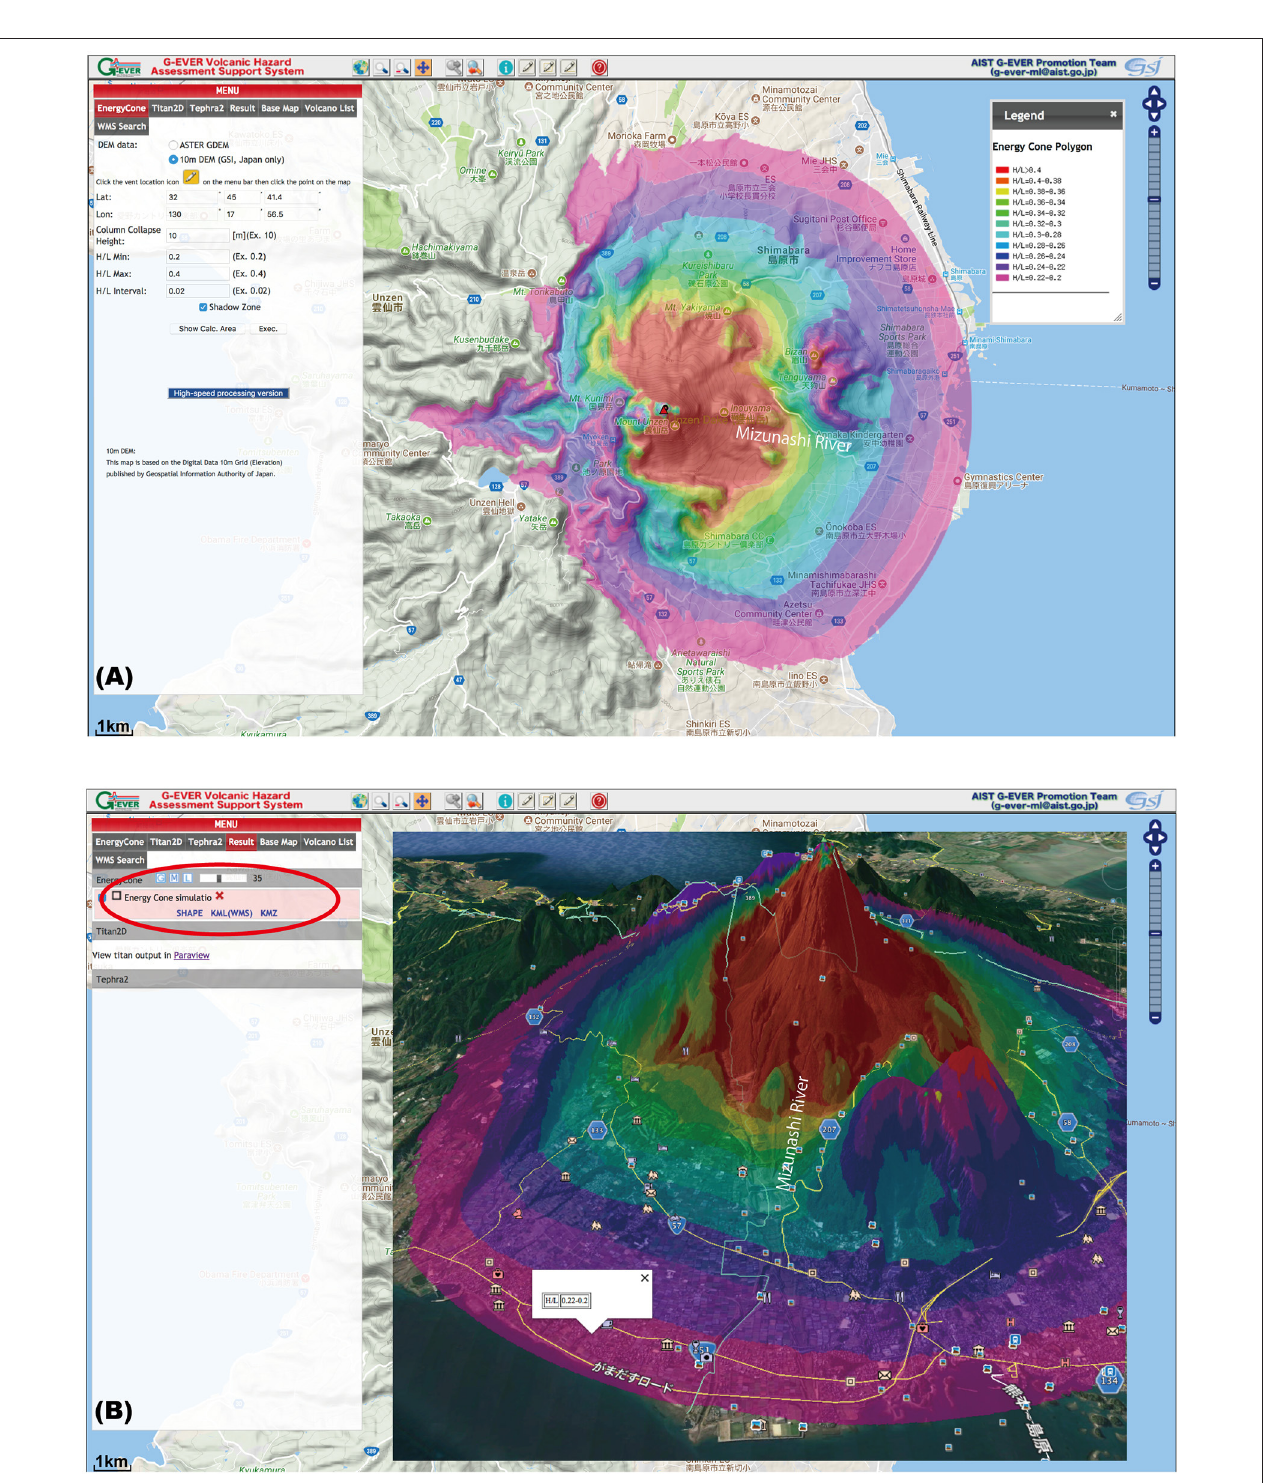
FIGURE 6 | An energy-cone simulation result at Unzen Volcano, Japan, using VHASS. (A) Energy Cone simulation menu with the result of the simulation displayed on the map. (B) Eastern view of the simulation result in 3D using Google Earth. The result can be downloaded as Shape, KML (using Web Map Service) and KMZ files. The users can evaluate detailed volcanic hazards assessments using GIS software and Google Earth overlaying the simulation result on maps showing roads, buildings, and evacuation sites.